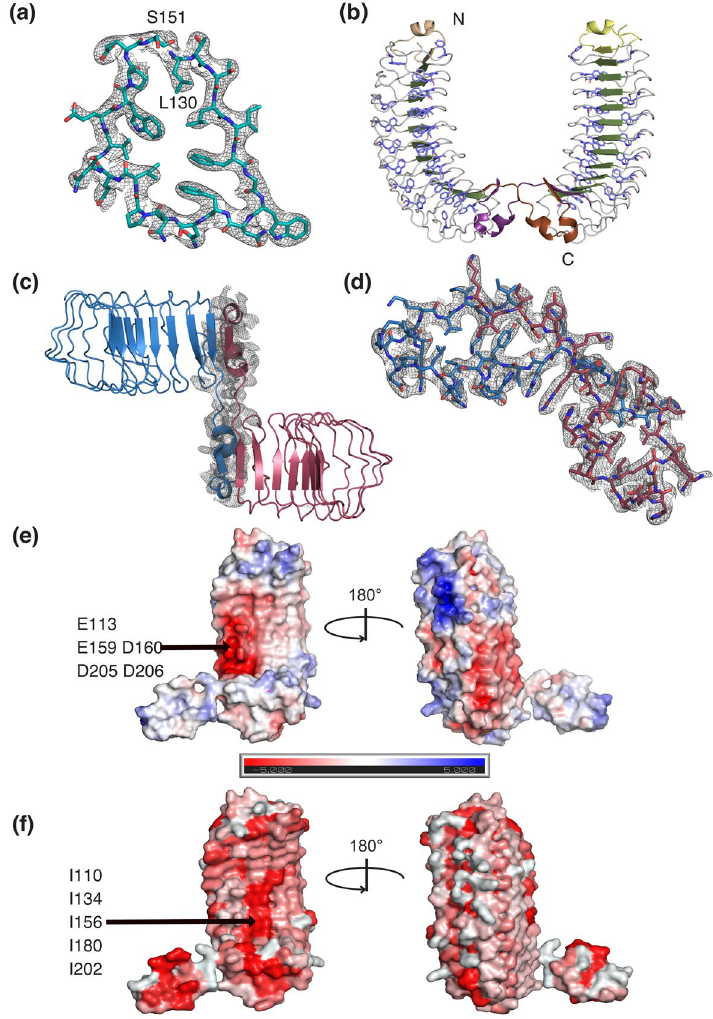
Figure 4. Structure of the Crov539 FGxxFN LRR protein. ( a ) Zoomed view of an individual repeat is presented with 2Fo-Fc density contoured at 1.0σ. ( b ) Ribbon representation of the Crov539 structure. Highlighted are N and C-terminal capping repeats (wheat-purple, yellow–brown), the phenylalanine/tryptophan spine (Slate). ( c ) Representation of the Crov563 dimer with individual chains colored blue and raspberry, 2Fo-Fc density at the dimer interface is contoured at 1.0σ. ( d ) A close-up of the motif swapped dimer region illustrated in sticks with 2Fo-Fc density at the dimer interface is contoured at 1.0σ. ( e ) Charged surface features of the Crov539 structure calculated with APBS, highlighting the pronounced negatively charged patch in the central curvature of the structure. ( f ) Hydrophobic surface features of the Crov539 structure colored according to the Eisenberg hydrophobicity scale with red being most